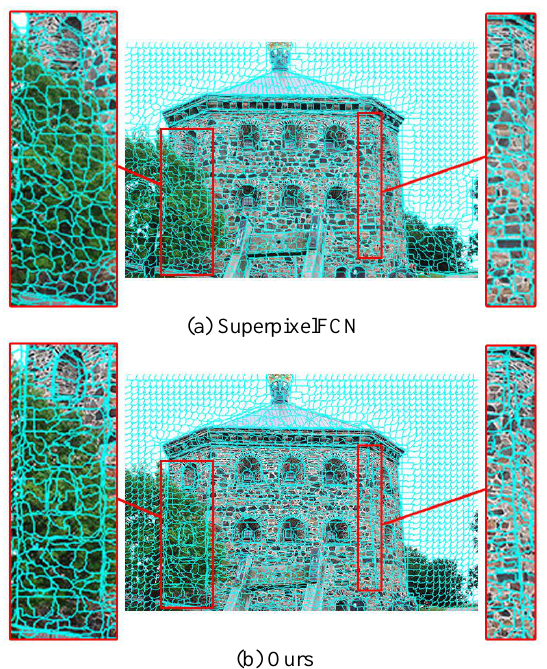
Figure 9 . Comparison of the results for the proposed method and the traditional FCN superpixel segmentation method.